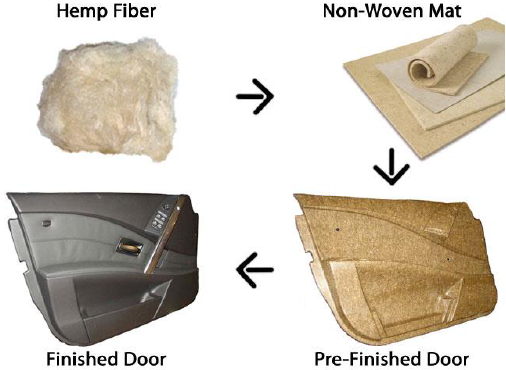
Figure 6. Production of door from hemp fibre [94].